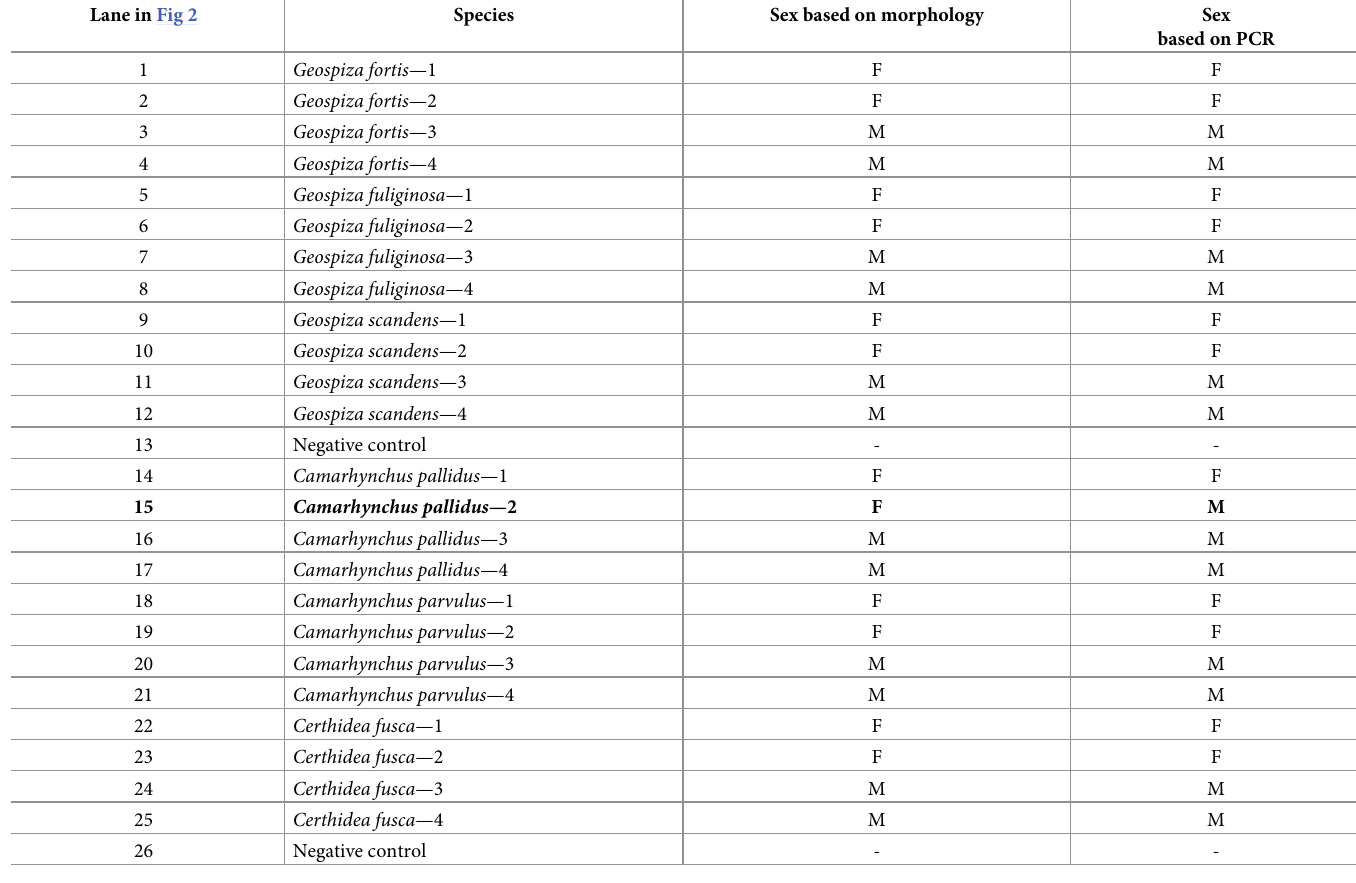
F—female; M—male.